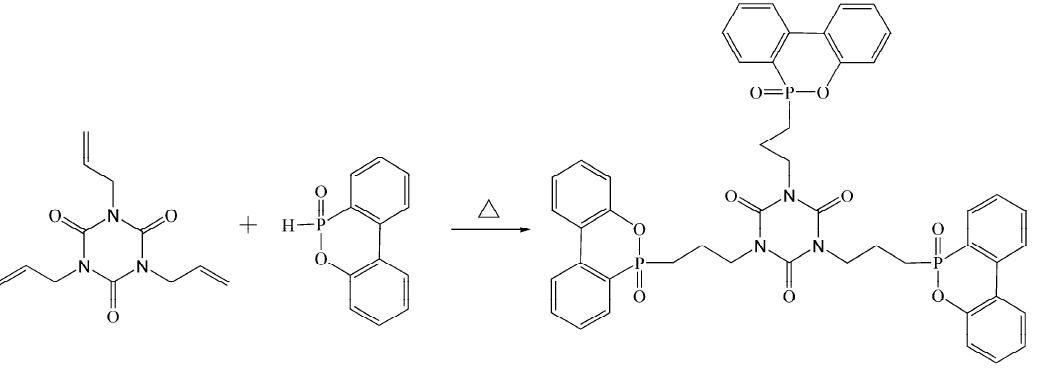
Figure 1. Synthesis route of TAD.